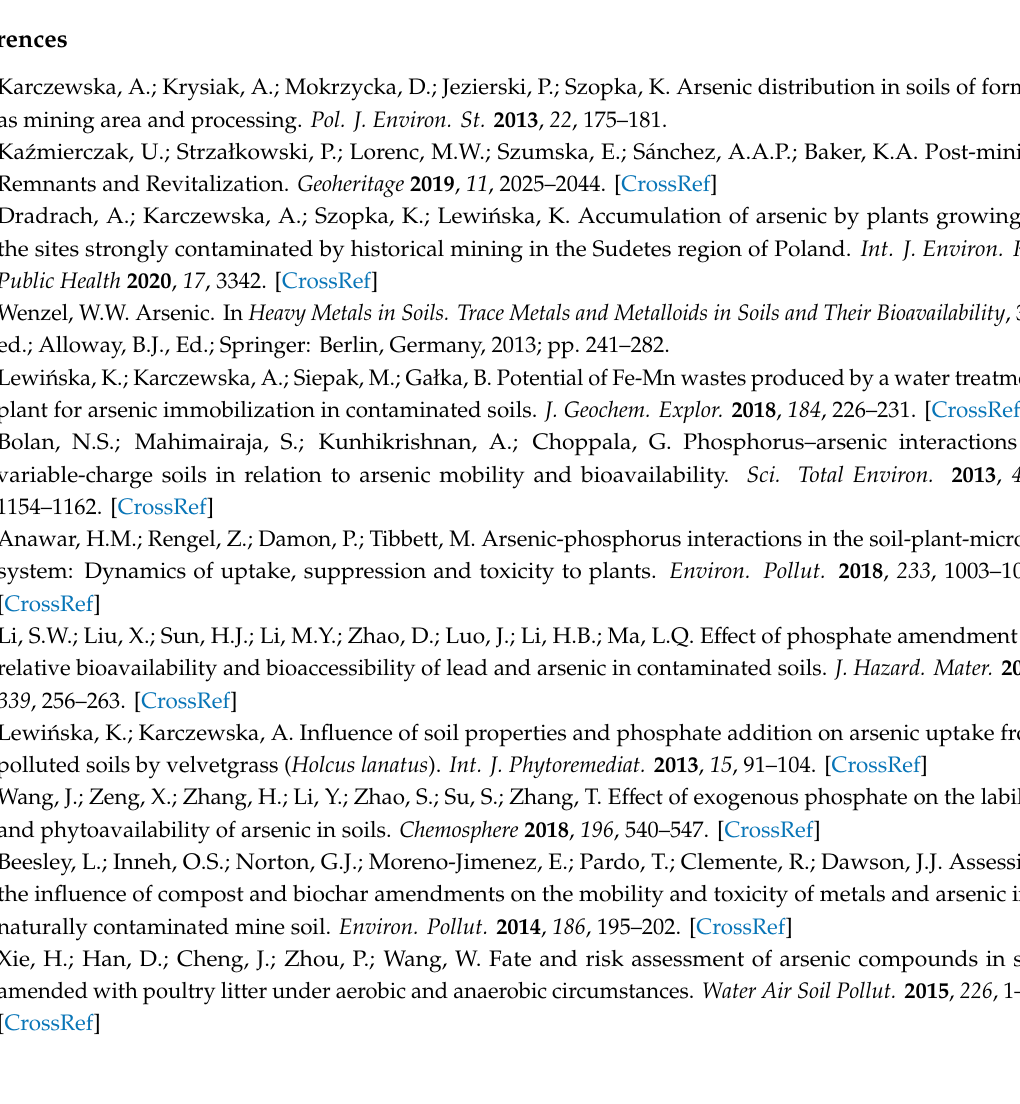
Table S1: The components of solution applied to soils for mineral fertilization (F), and corresponding fertilization rates; Table S2: Chemistry of soil pore water. The values of pore water pH and the concentrations of As and potentially toxic